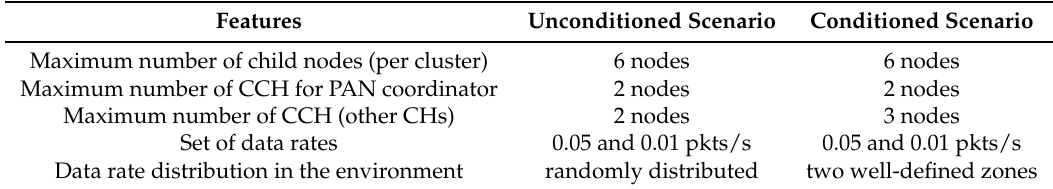
Table 3. Summarising the different Simulation Scenarios.